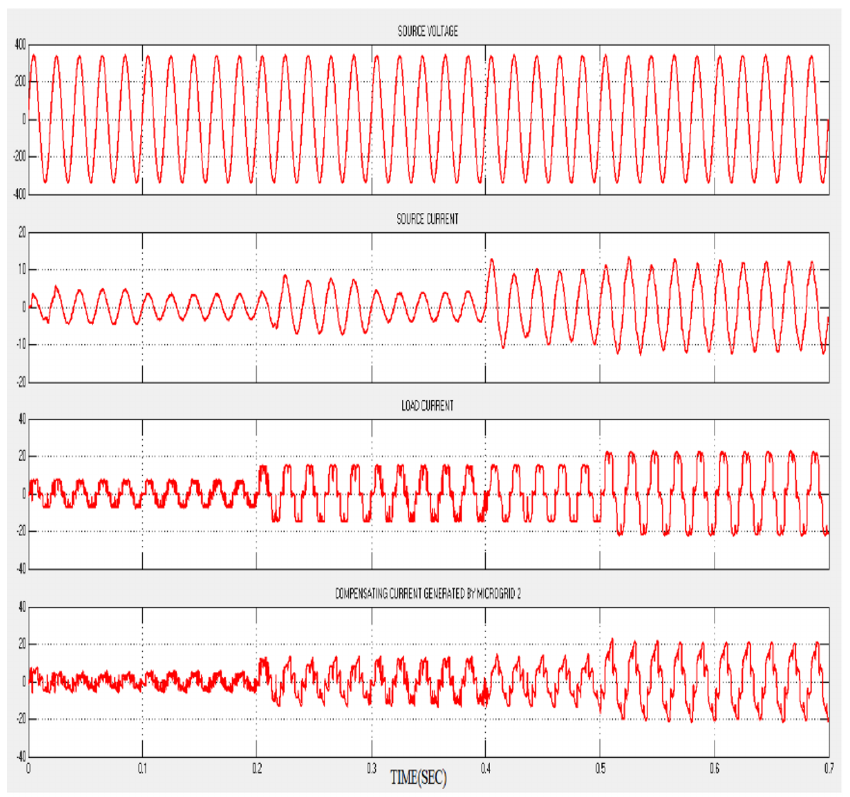
Figure 16. Voltage and Current waveforms of phase when Microgrid 2 is integrated into the